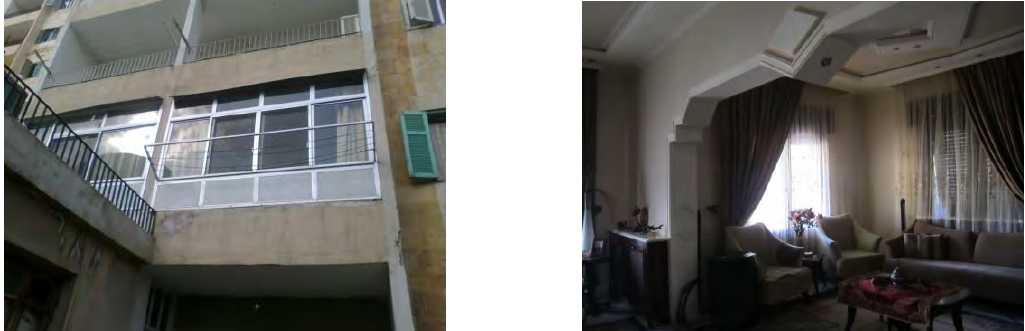
Figure 8: Modification done by users: closing balconies(left) removing the wall between two rooms(right) 5Children´s Playground: The plaza in between buildings designed as a green area was used as playgrounds by children and football camps even though it has no equipment. This is because of the high temperature which needs a shaded area for playing and all playgrounds were collected in the central part of the quarter which has a higher level of vegetation and trees providing suitable shadow level. Also with the clear separation between the cars and pedestrians, many children are riding their bicycles in the